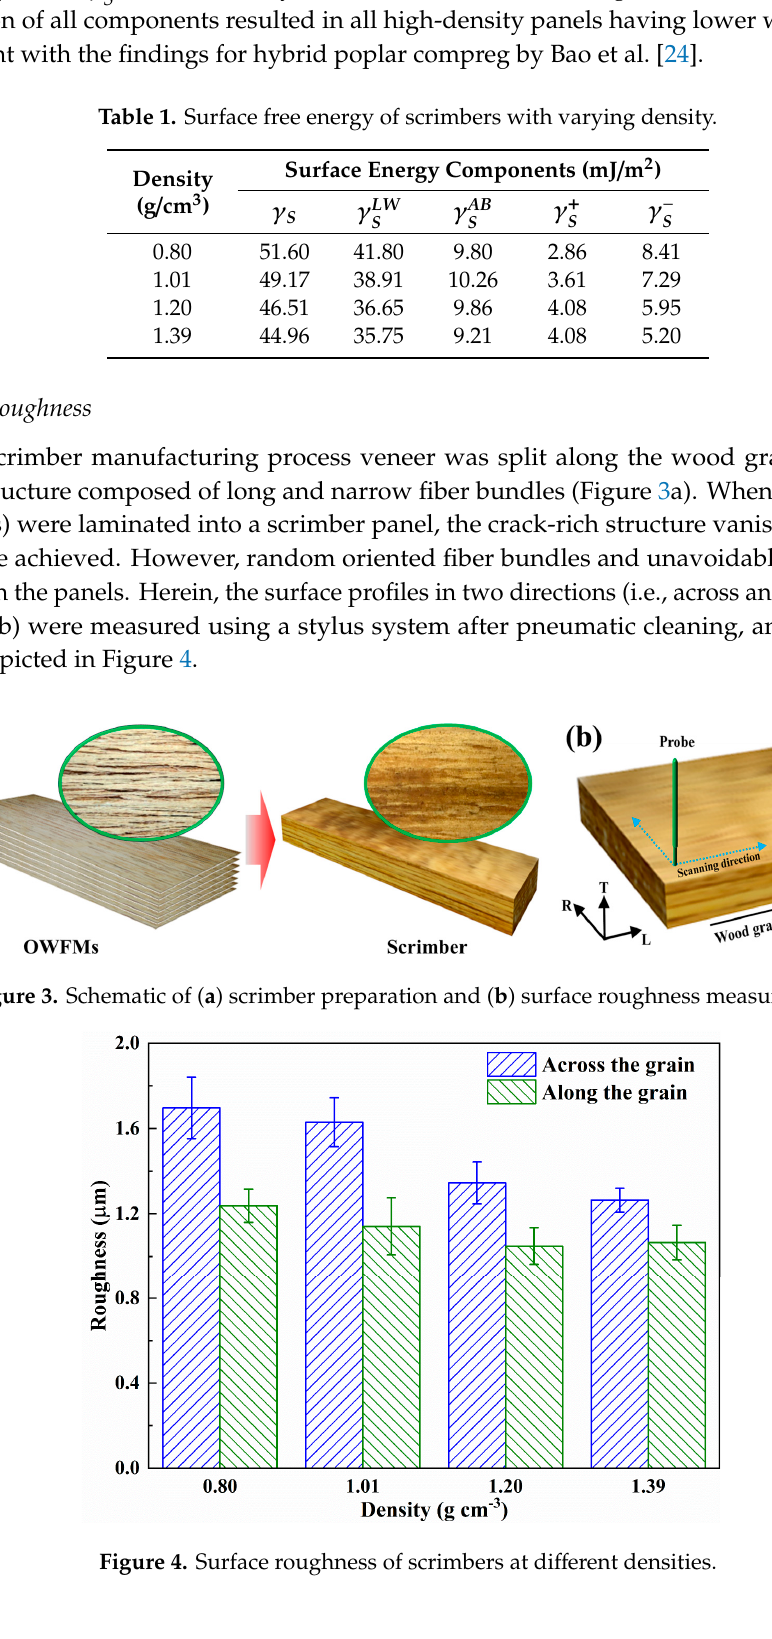
Table 1. Surface free energy of scrimbers with varying density.